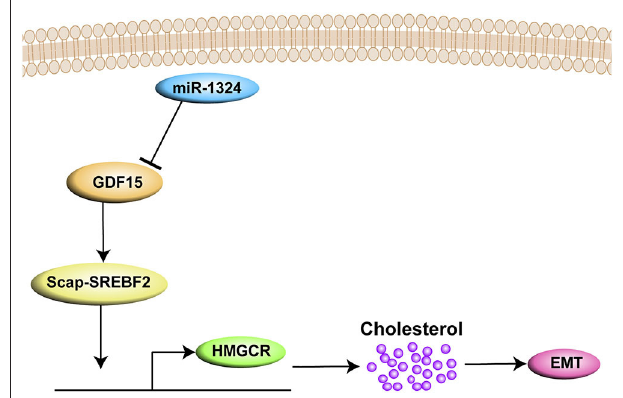
FIGURE 7 | A graph illustrates that SCAP mediated GDF15-induced EMT of EC by regulating cholesterol metabolism. In addition, GDF15 was shown to be a direct target of